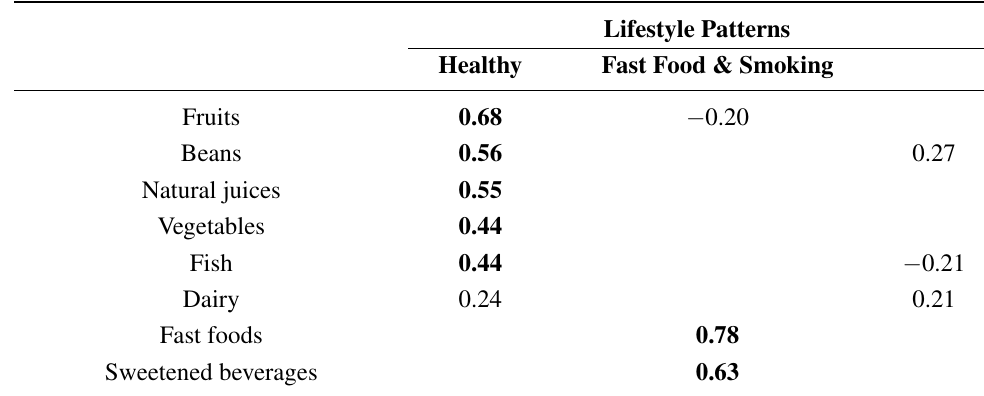
Table 2. Weighted factor loading matrix of the three identified lifestyle patterns among a nationally representative sample of Qatari women a ( n =